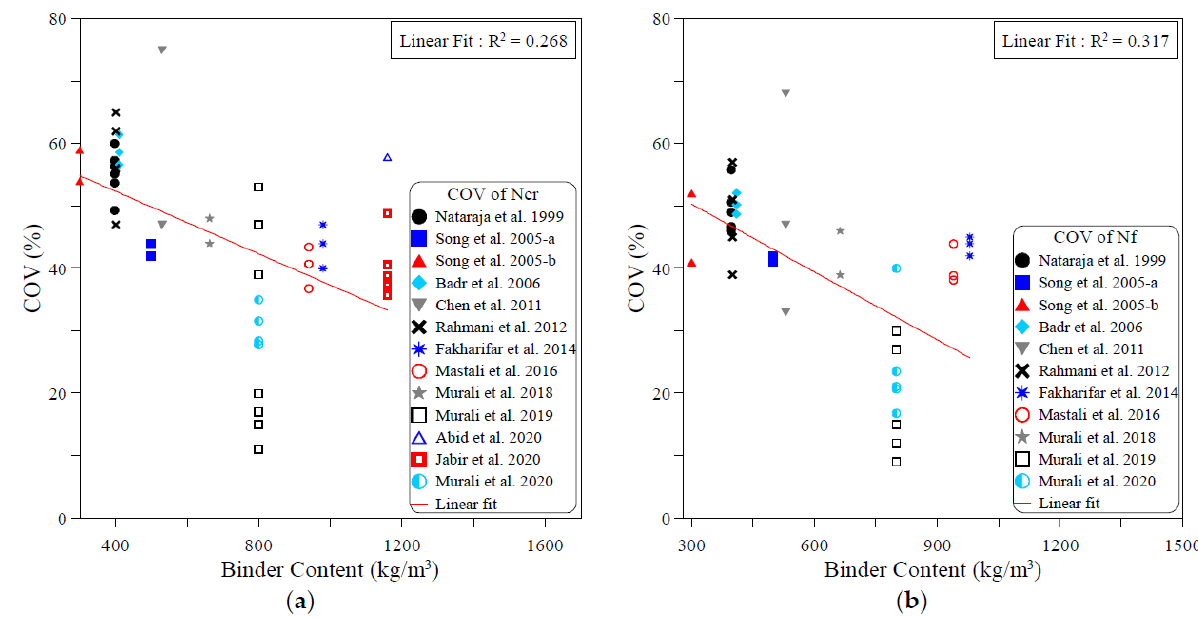
Figure 1. Effect of compressive strength on the scattering of impact results at ( a ) cracking and ( b ) failure.